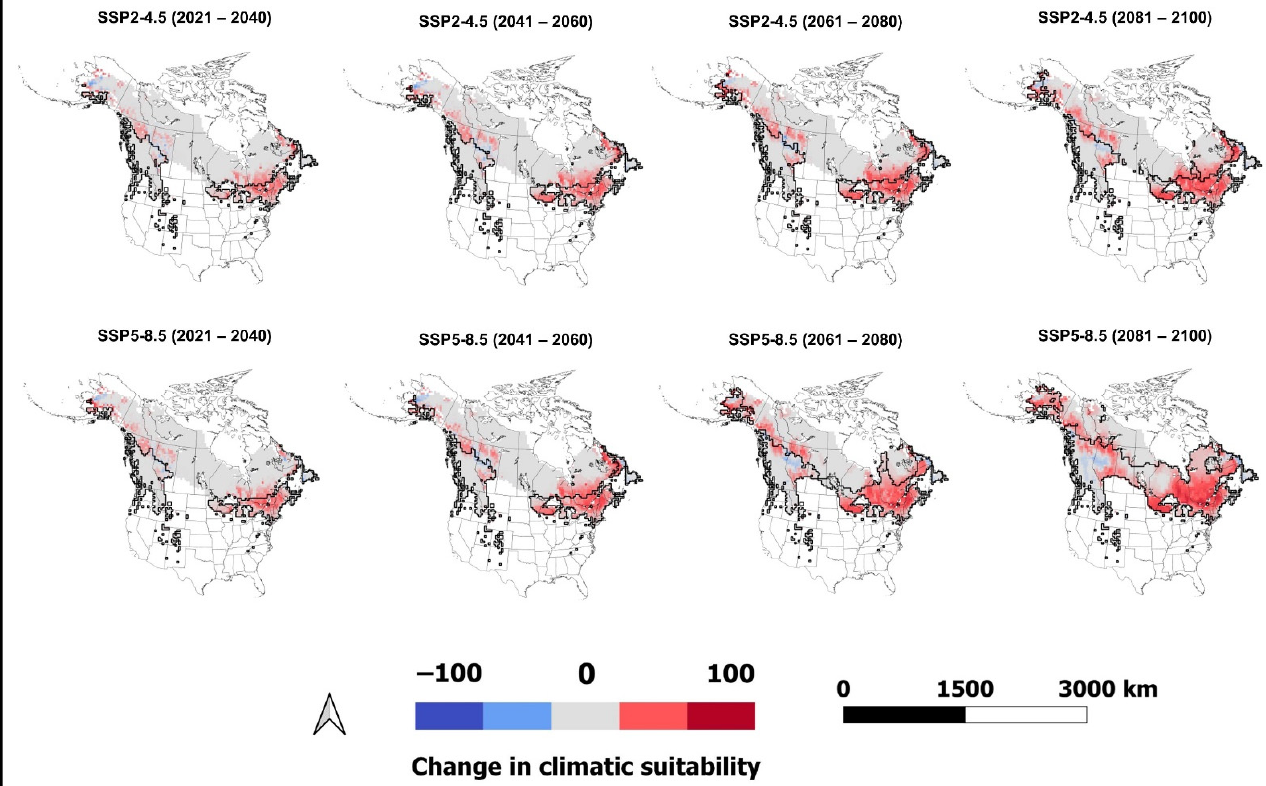
Figure 7. Maps of changes in climatic suitability for Ips typographus during four future periods (2021–2040, 2041–2060, 2061–2080, and 2081–2100) with respect to the current period (1970–2000), clipped to the spruce range in Canada and the United States. Thick black lines overlapping the I. typographus maps represent climatically suitable areas for Endoconidiophora polonica . SSP2-4.5 and SSP5-8.5 are shared socio-economic pathway (SSP) scenarios that project moderate (2.6 °C) and high (5 °C) global mean temperature increases by the end of the 21st century, respectively.